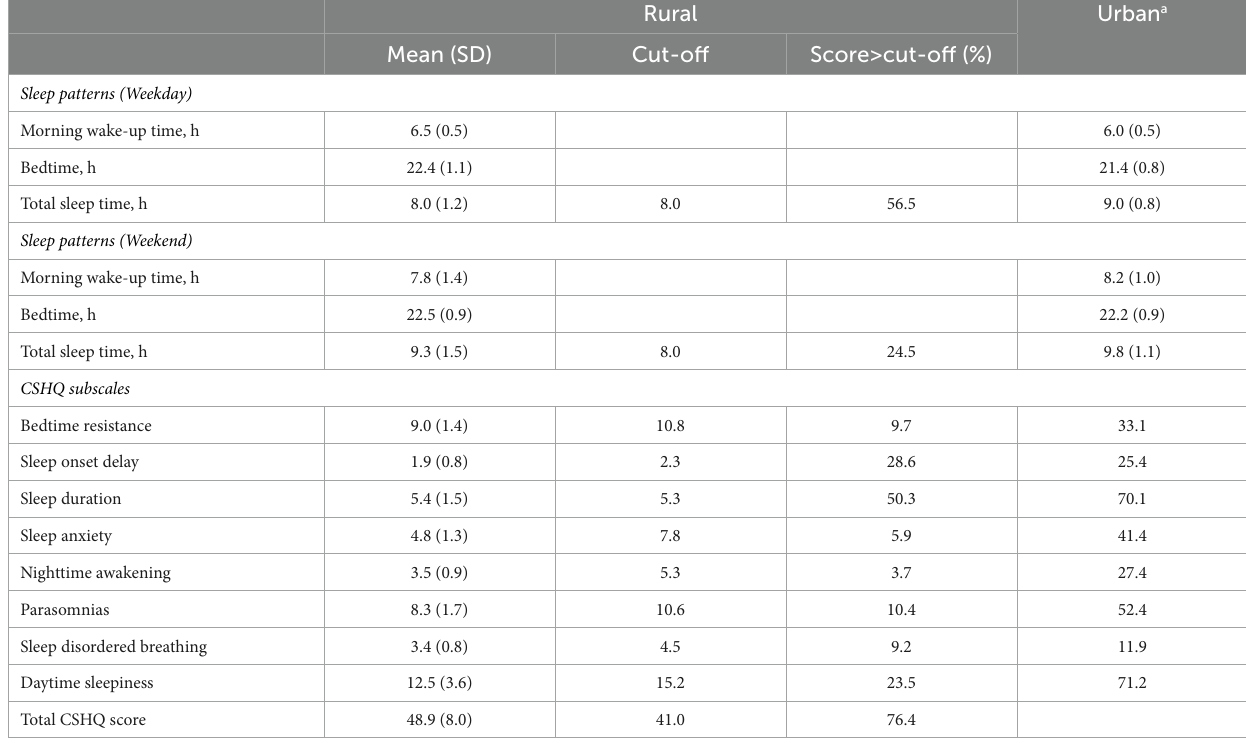
TABLE 2 CSHQ score and sleep pattern.